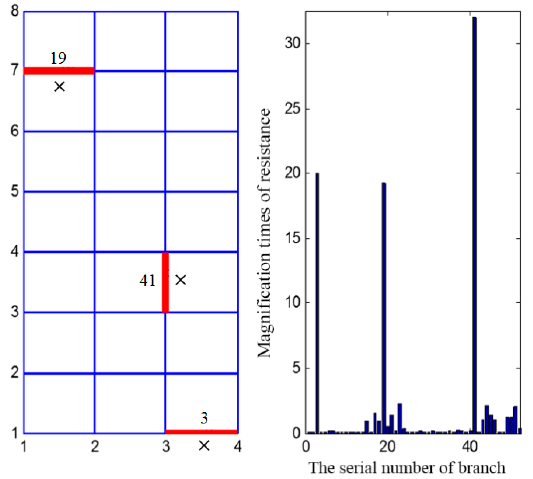
Figure 14. The results of the multiple branch faults case with the galvanized steel strap network.